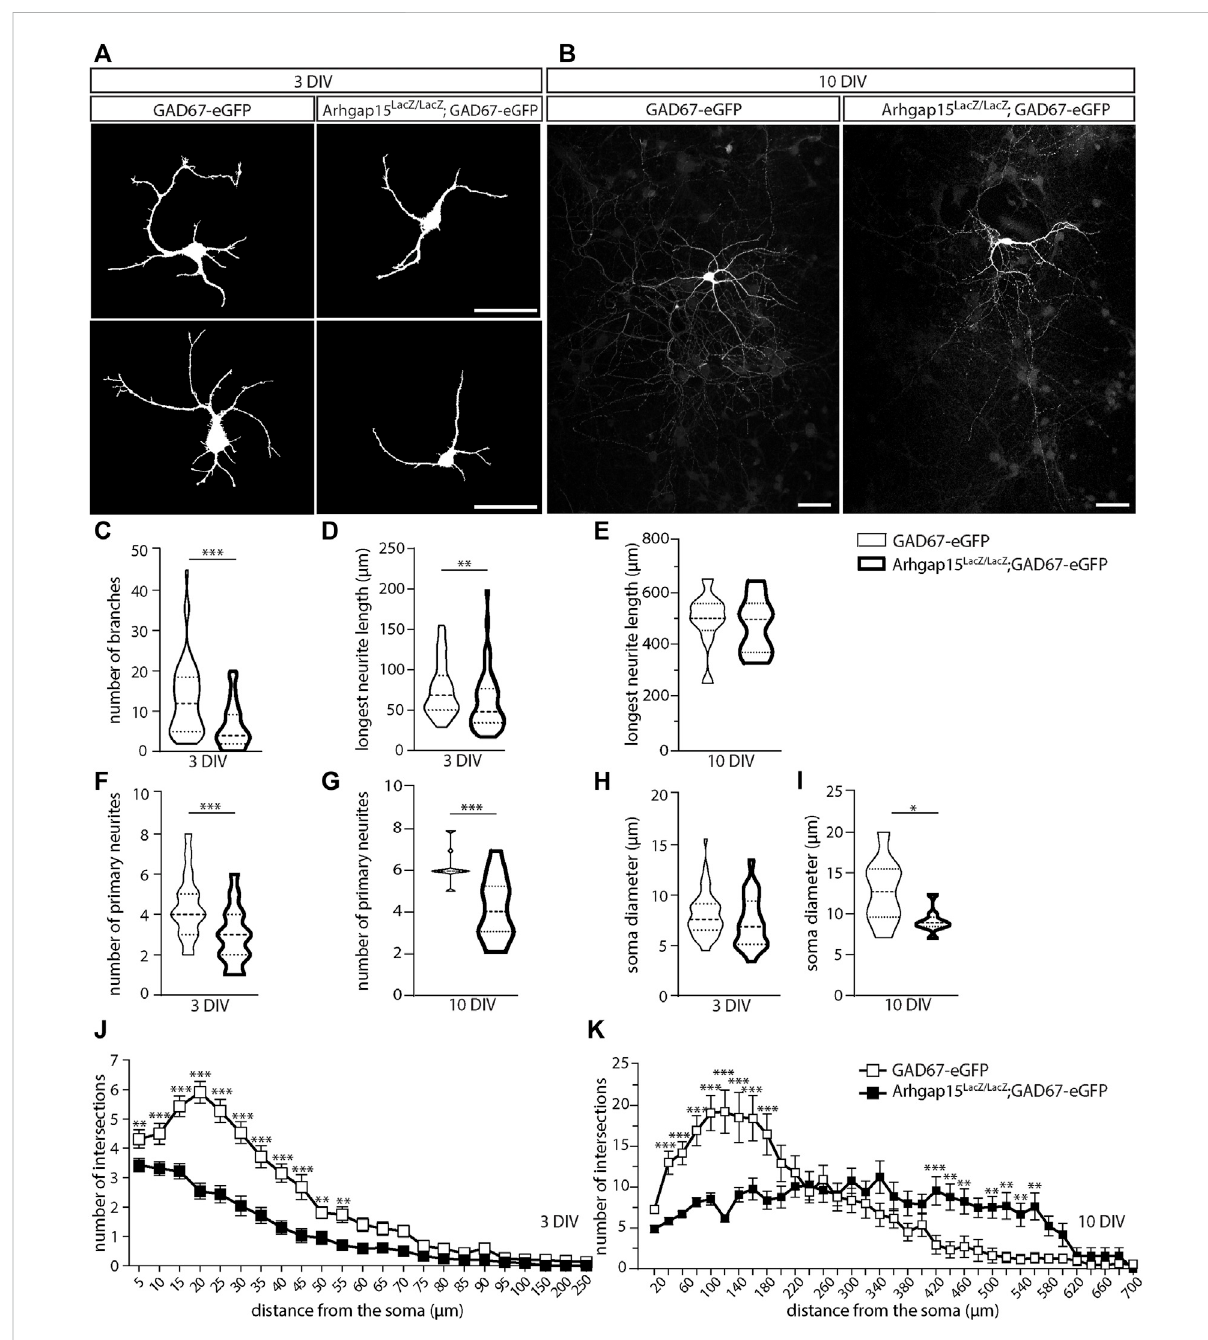
FIGURE 3 Morphological analysis of primary CINs. (A,B) Representative fl uorescence micrographs of eGFP-positive primary CINs from GAD67-eGFP (control) and Arhgap15 LacZ/LacZ ; GAD67-eGFP mice after 3 (A) and 10 (B) DIV. Scale bars: 20 µm. (C) Number of branches in GAD67-eGFP and Arhgap15 LacZ/LacZ ; GAD67-eGFP primary CINs after 3 DIV. p = 8 × 10 − 6 . (D,E) Length of the longest neurite in GAD67-eGFP and Arhgap15 LacZ/LacZ ; GAD67-eGFP primary CINs after 3 (D; p = 7 × 10 − 3 ) and 10 (E; p = 0.75) DIV. (F,G) Number of primary neurites in GAD67-eGFP and Arhgap15 LacZ/LacZ ; GAD67-eGFP primary CINs after 3 (F; p = 3 × 10 − 6 ) and 10 (G; p = 4 × 10 − 4 )DIV. (H,I) Average diameter of the soma of GAD67-eGFP and Arhgap15 LacZ/LacZ ; GAD67-eGFP primary CINs after 3 (H; p = 0.08) and 10 (I; p = 0.04) DIV. (J,K) Sholl analysis showing the overall complexity of arborization in GAD67-eGFP and Arhgap15 LacZ/LacZ ; GAD67-eGFP primary CINs after 3 DIV (J; p (from 5 to 250 µm) = 0.03, 6 × 10 − 3 , 2 × 10 − 6 , 1 × 10 − 6 , 1×10 − 6 ,3×10 − 6 ,3×10 − 5 ,5×10 − 6 ,6×10 − 4 ,5×10 − 3 ,2×10 − 3 ,7×10 − 3 ,0.02,7×10 − 3 ,0.05,0.04,0.06,0.01,0.17,0.30,0.03,0.10,0.10)and10DIV(K; p (from 10 to 700 µm) = 0.23, 2 × 10 − 4 , 2 × 10 − 4 , 1 × 10 − 5 , 1 × 10 − 6 , 2 × 10 − 6 , 1 × 10 − 5 , 5 × 10 − 5 , 0.04, 0.39, 0.70, 0.51, 0.88, 0.23, 0.49, 0.20, 0.18, 0.07, 0.20, 9 × 10 − 4 , 0.20, 1 × 10 − 3 , 5 × 10 − 3 , 8 × 10 − 3 , 3 × 10 − 3 , 2 × 10 − 3 , 6 × 10 − 3 , 1 × 10 − 3 , 0.04, 0.14, 0.80, 0.59, 0.59, 0.64, 0.79). At least 70 (3 DIV) and 35 (10 DIV) neurons from 3 independent primary cultures were analyzed for each genotype. Data are presented as mean ± SEM. p -values were calculated using unpaired Mann – Whitney test (C – I) and unpaired multiple t -test corrected for False Discovery Rate ( < 1%) (J,K) . * = p < 0.05, ** = p < 0.01, *** = p < 0.001. DIV, days in vitro